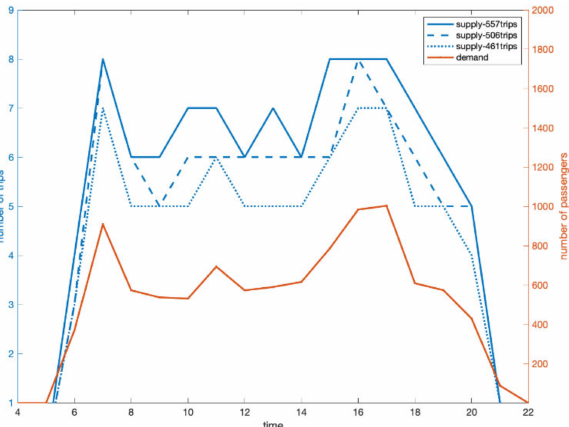
Figure 20. The comparison of supply and demand with different trips.